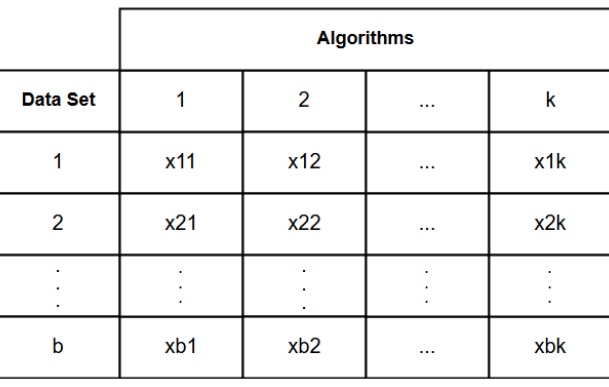
Figure 3. Friedman test